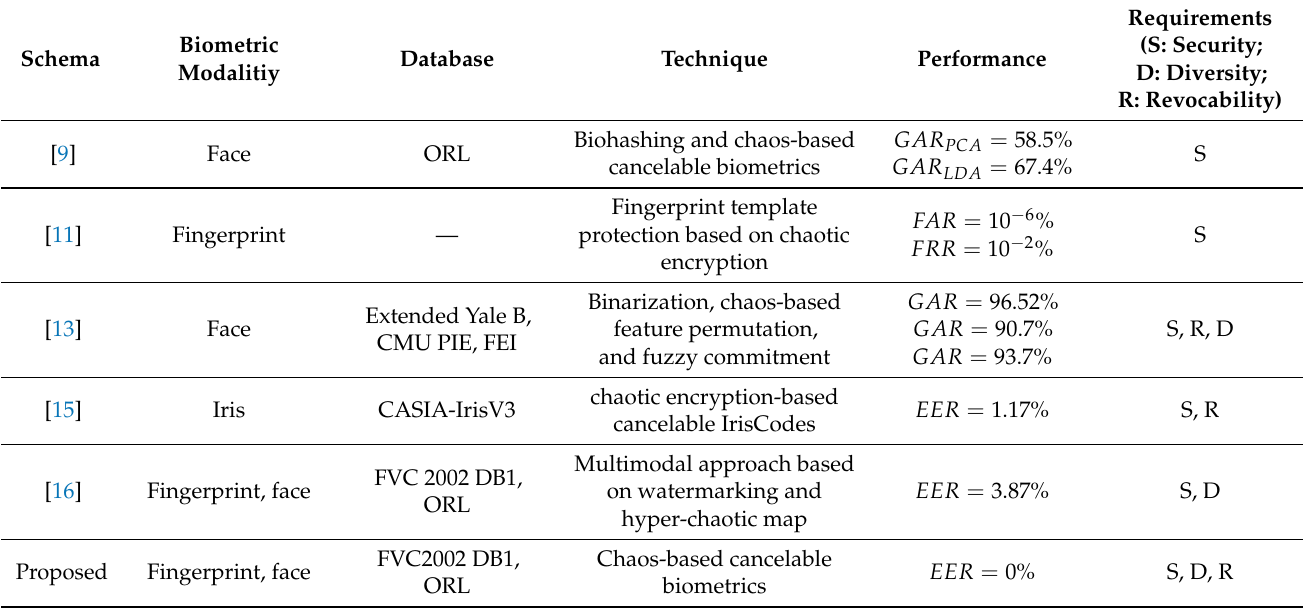
Table 1. Comparison of the proposed approach with related